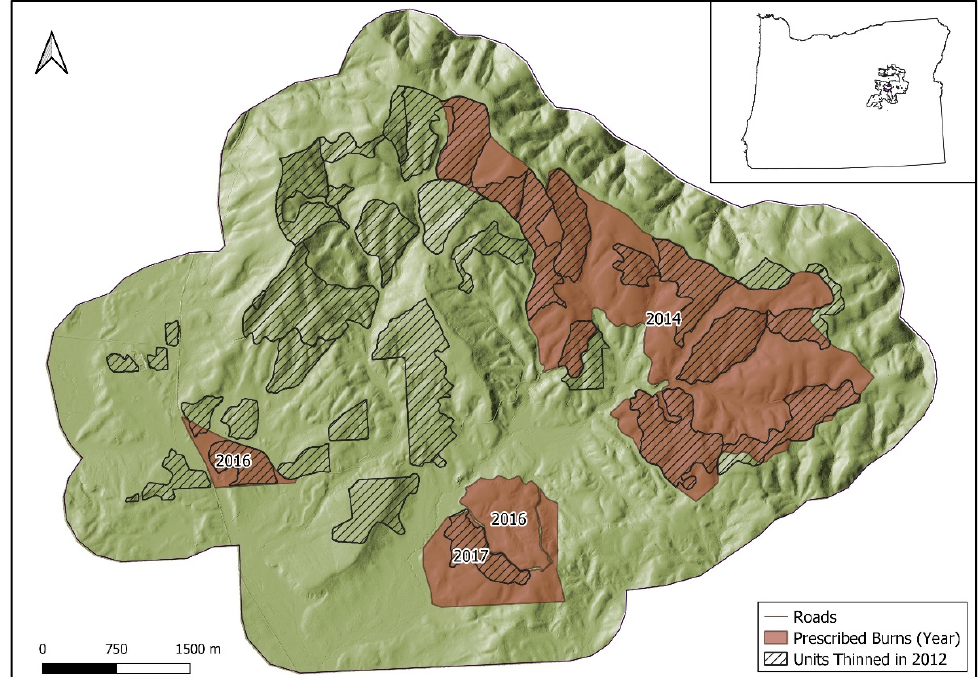
Figure 1. Map of the Damon planning area with locations and perimeters of commercial thinning treatments and prescribed burn units on the Malheur National Forest near John Day, OR, USA. The inset map shows the location of the study area and the Malheur National Forest within the state of Oregon.